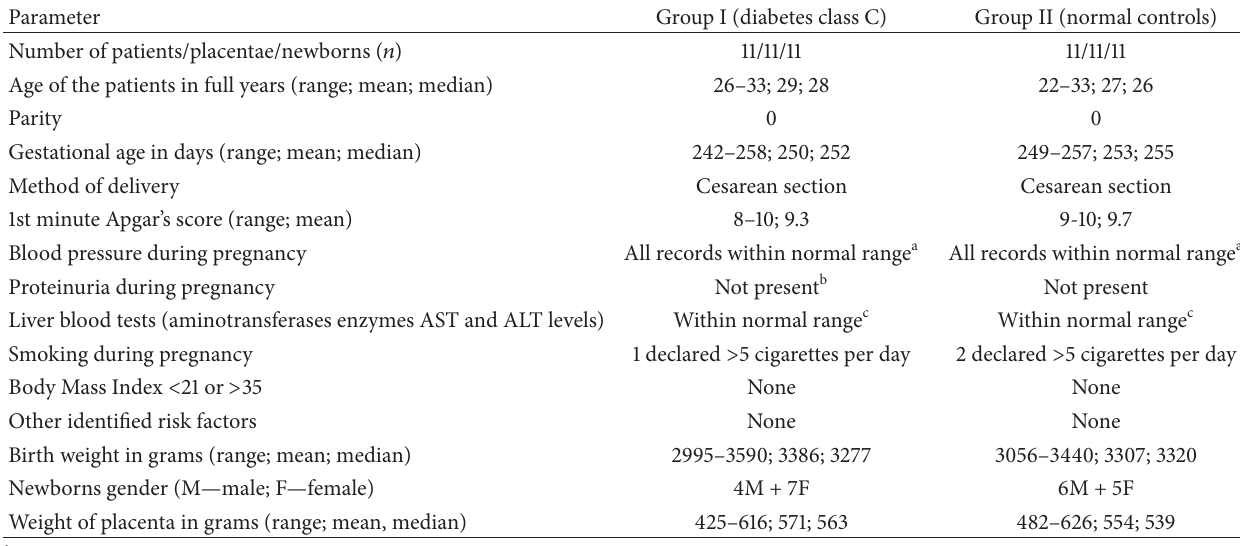
Table 1: Clinical characteristics of the two studied groups: diabetes class C after White (group I) versus normal-course pregnancies (group